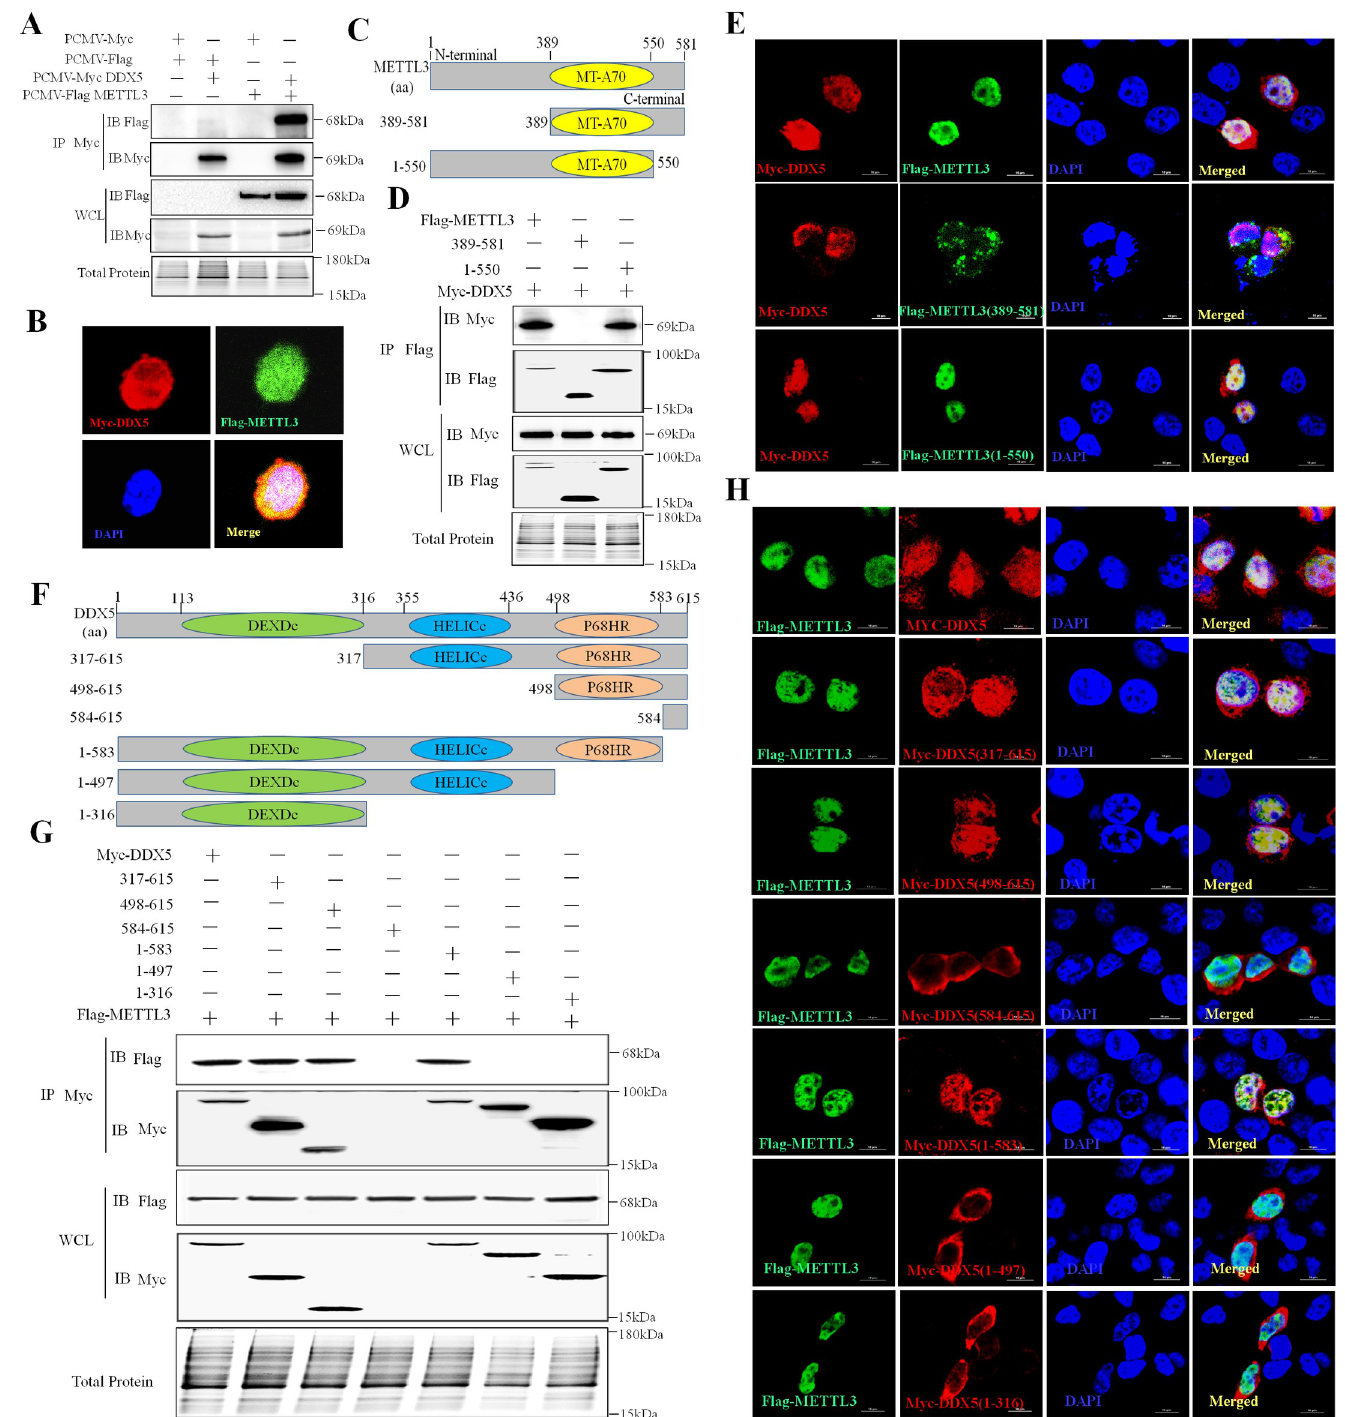
Fig 2. DDX5 directly interacts with METTL3. A: Co-IP of DDX5 and METTL3 in HEK293T cells. B: Co-localization of DDX5 and METTL3 in HEK293T cells cultured in slices and co-transfected with Myc-DDX5 and Flag-METTL3 plasmids. After 24 h, slices were fixed, permeabilized, and incubated with rabbit anti-Myc and mouse anti-Flag antibodies followed by Alexa Fluor 546 labeled goat anti-rabbit IgG (H+L), Alexa Fluor 488 labeled goat anti-mouse IgG (H+L). Nuclei were stained with DAPI; cells were observed by LSCM. Scale bars, 5 μ m. C: Schematic of full-length METTL3 and its truncated mutants. D: Co-IP of DDX5 and METTL3 mutants in HEK293T cells. Cells were co-transfected with Myc-DDX5 and Flag-METTL3 mutants. After 24 h, cells were lysed and subjected toIP with Flag antibody, and whole-cell lysates and IP were analyzed by western blotting. E: Co-localization of DDX5 and METTL3 mutants in HEK293T cells. Scale bars, 10 μ m. F: Schematic